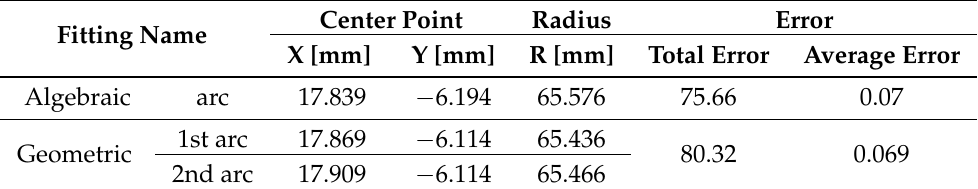
Table 1. Piecewise curve fitting result of back surface of the piggy bank (total 1164 points).